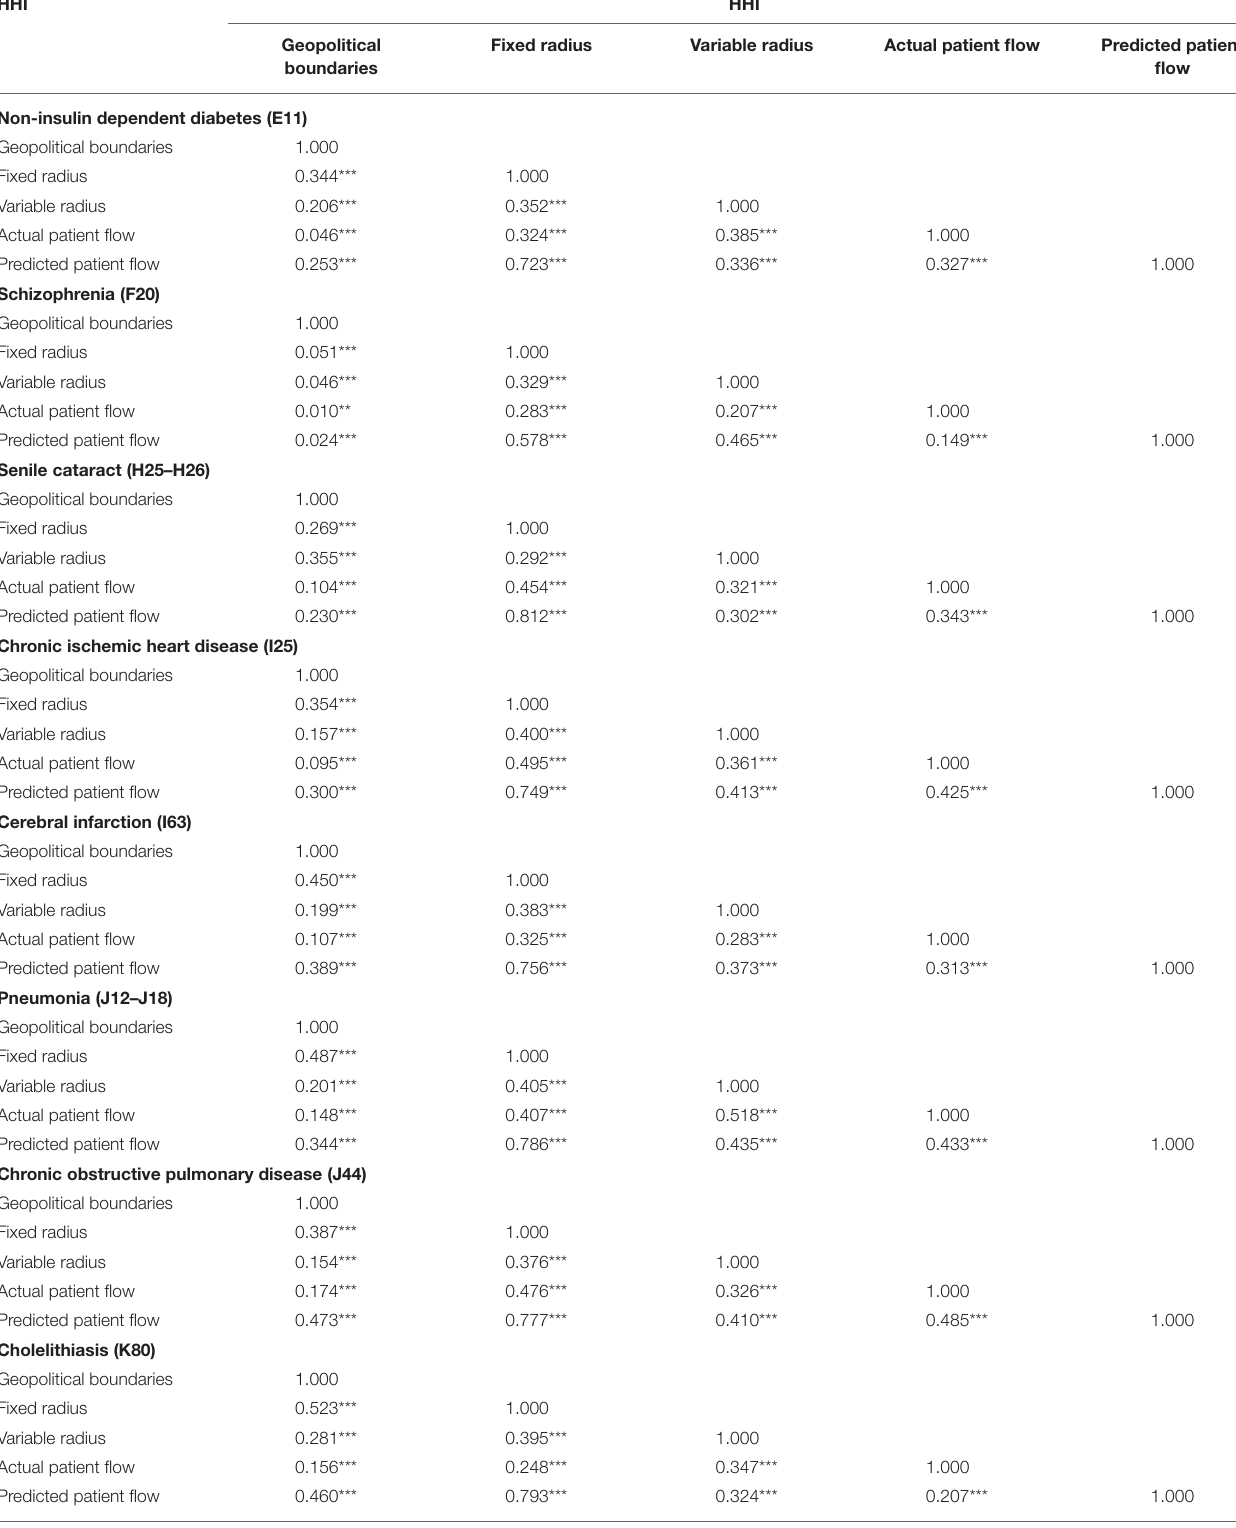
TABLE 5 | Excluding the inpatients living outside of Sichuan Province: the correlation coefficient matrix of HHIs. HHI HHI